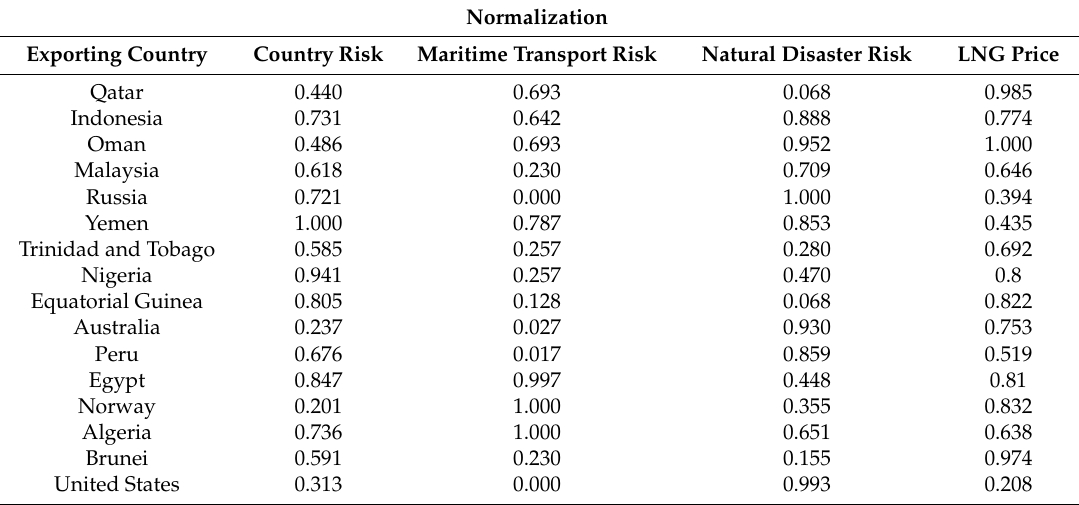
Table 7. Normalized values of the exporting country risks and prices.